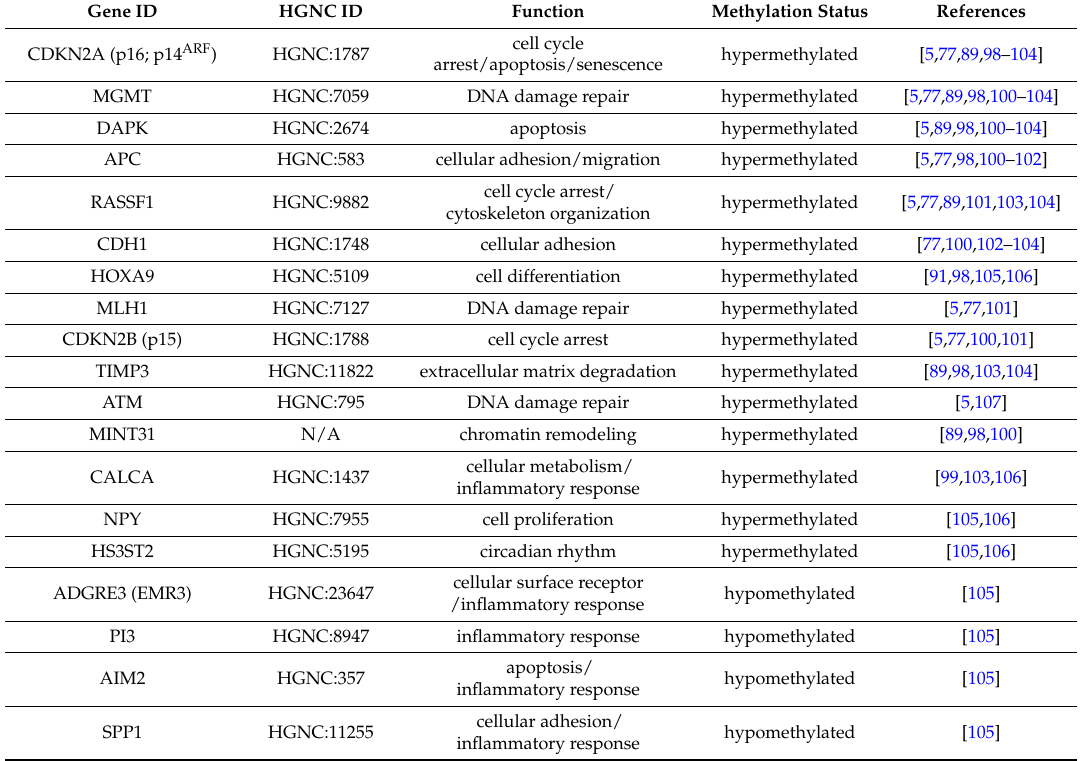
Table 1. List of the frequently altered genes by DNA methylation in HNSCC. N/A: not applicable. Gene ID HGNC